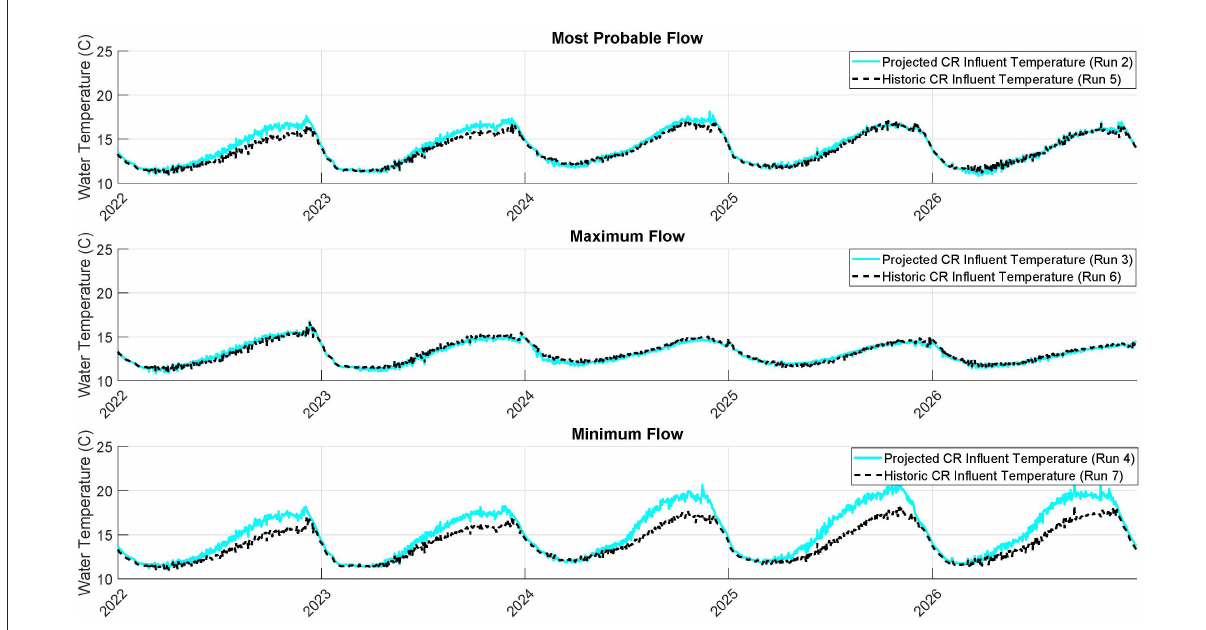
FIGURE10 Effects of Colorado River temperature model on raw water temperatures at Intake 3.